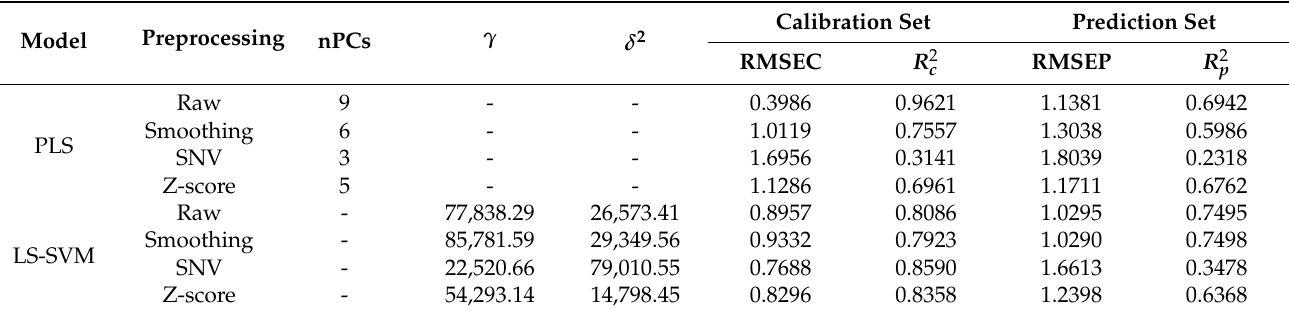
Table 1. Prediction parameters of PLS and LS-SVM with different preprocessing for the spectropho- tometer experiment.